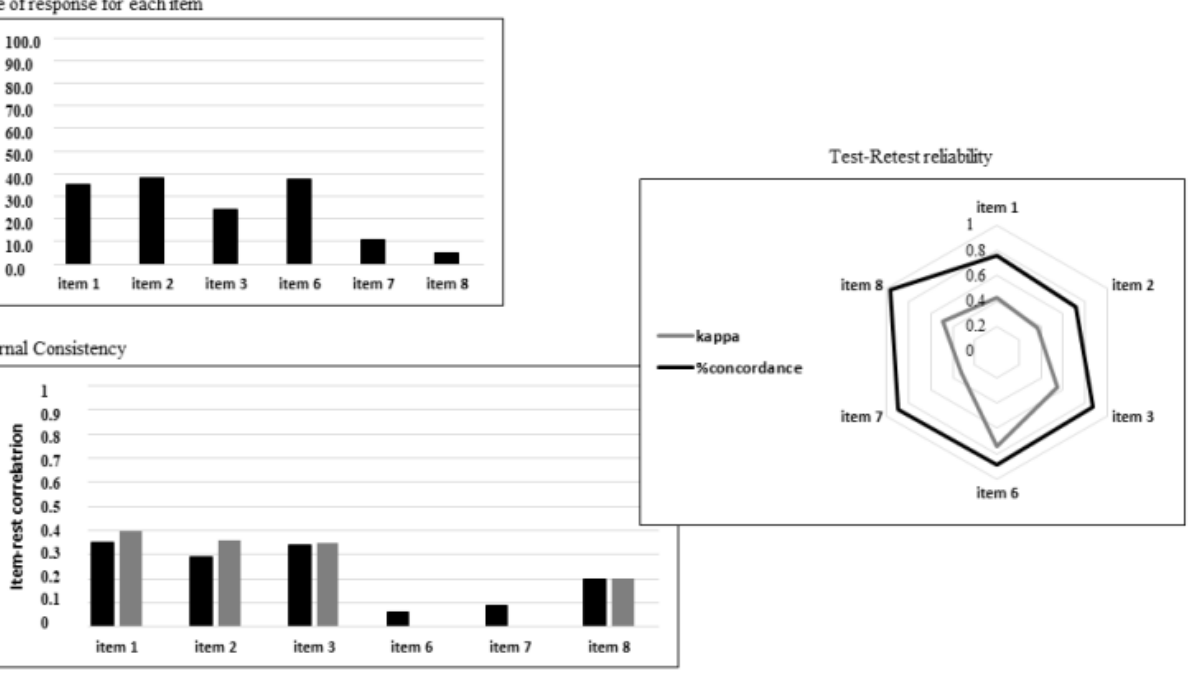
Figure 2. Psychometric properties.